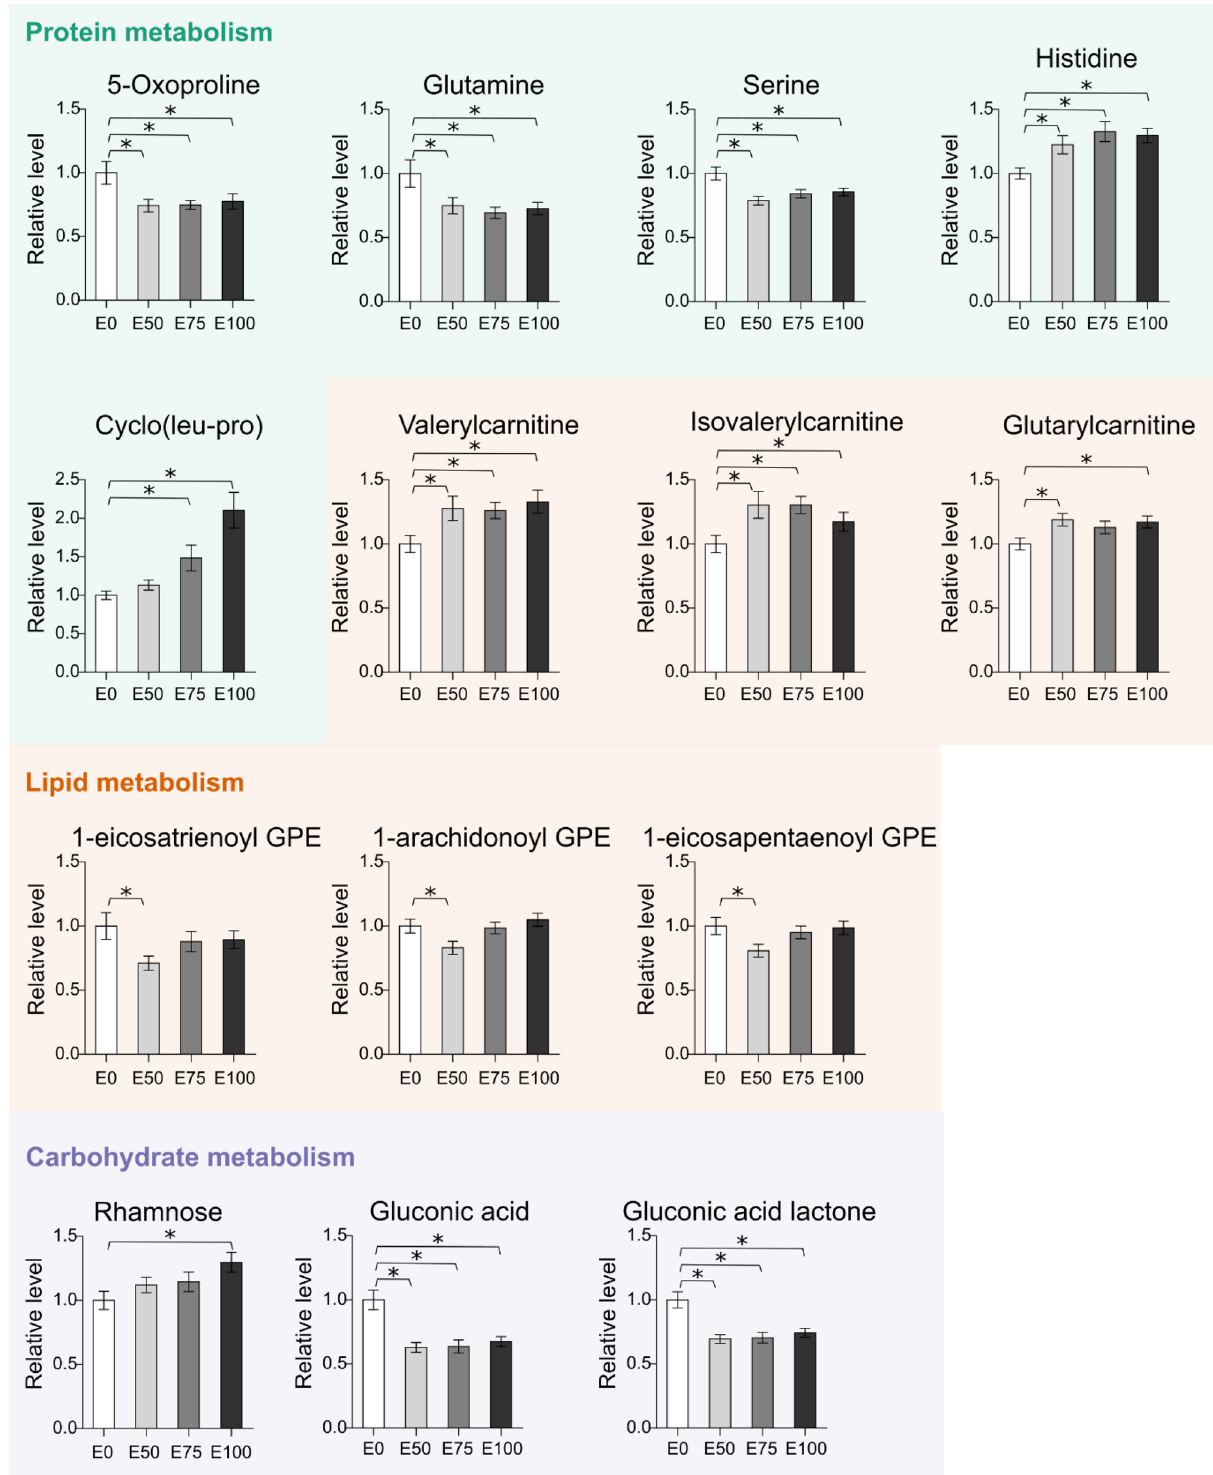
Figure 6. Relative levels of significantly affected metabolites in damselfly larvae exposed to dilutions of treated wastewater effluent (E100, E75, E50) in comparison to a tap water control (E0) (*p < 0.05; corrected for multiple comparisons using